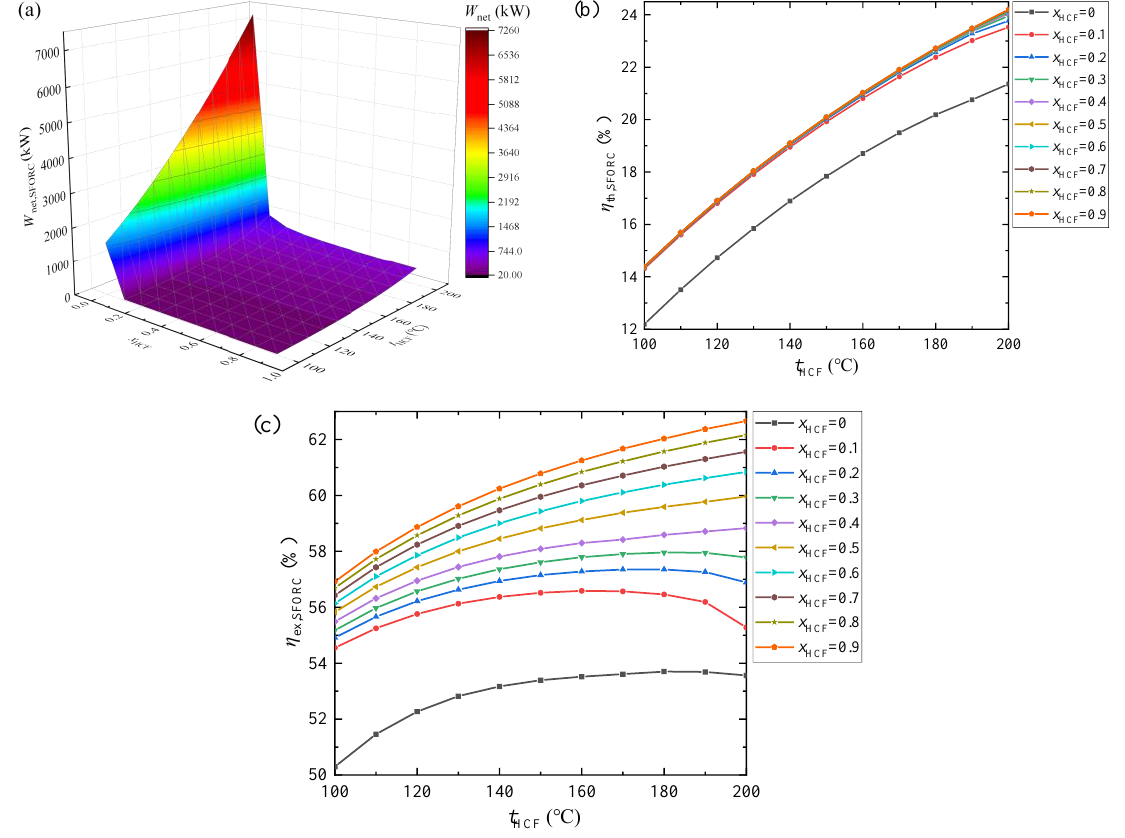
Figure 18. Variation of optimal thermodynamic parameters of the SFORC system with steam quality at different heat carrier temperatures: ( a ) W net, SFORC , ( b ) η th, SFORC and ( c ) η ex, SFORC.